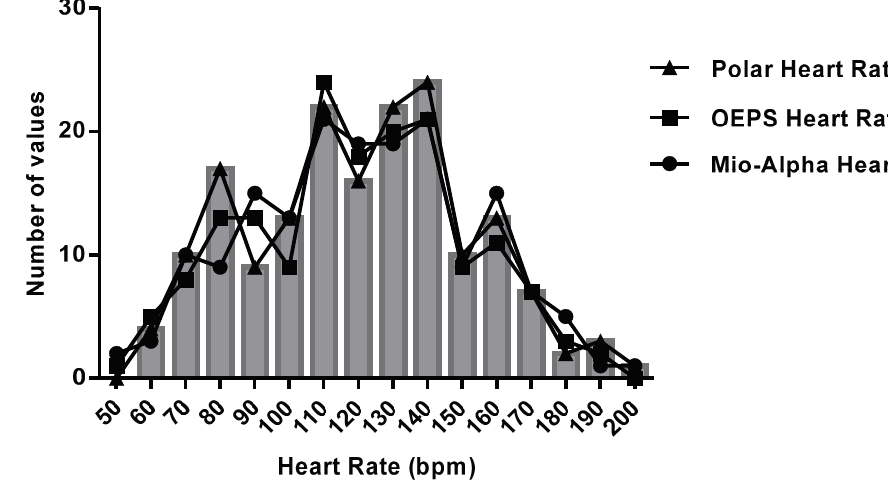
Figure 21. Histogram distribution for HR using Polar, Mio-Alpha and OEPS